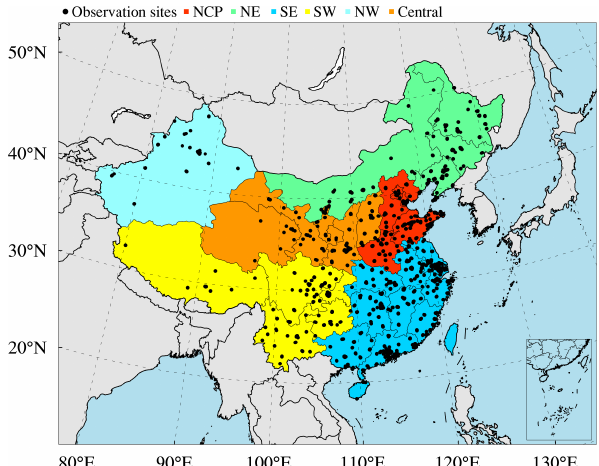
Figure 1. Modelling domain of the ensemble simulation overlain on the distribution of the observation sites of the CNEMC. The dif- ferent colours denote the different regions in China, namely, the North China Plain (NCP), northeast China (NE), southwest China (SW), southeast China (SE), northwest China (NW), and central